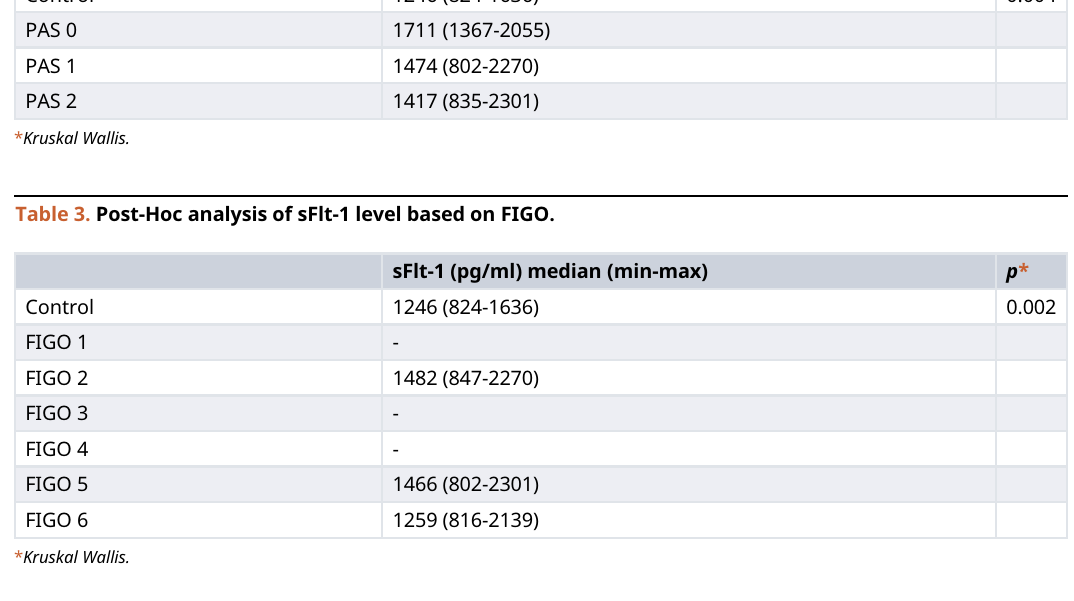
Table 4. Correlation of PAS and FIGO on sFlt-1 serum levels in patients with placental